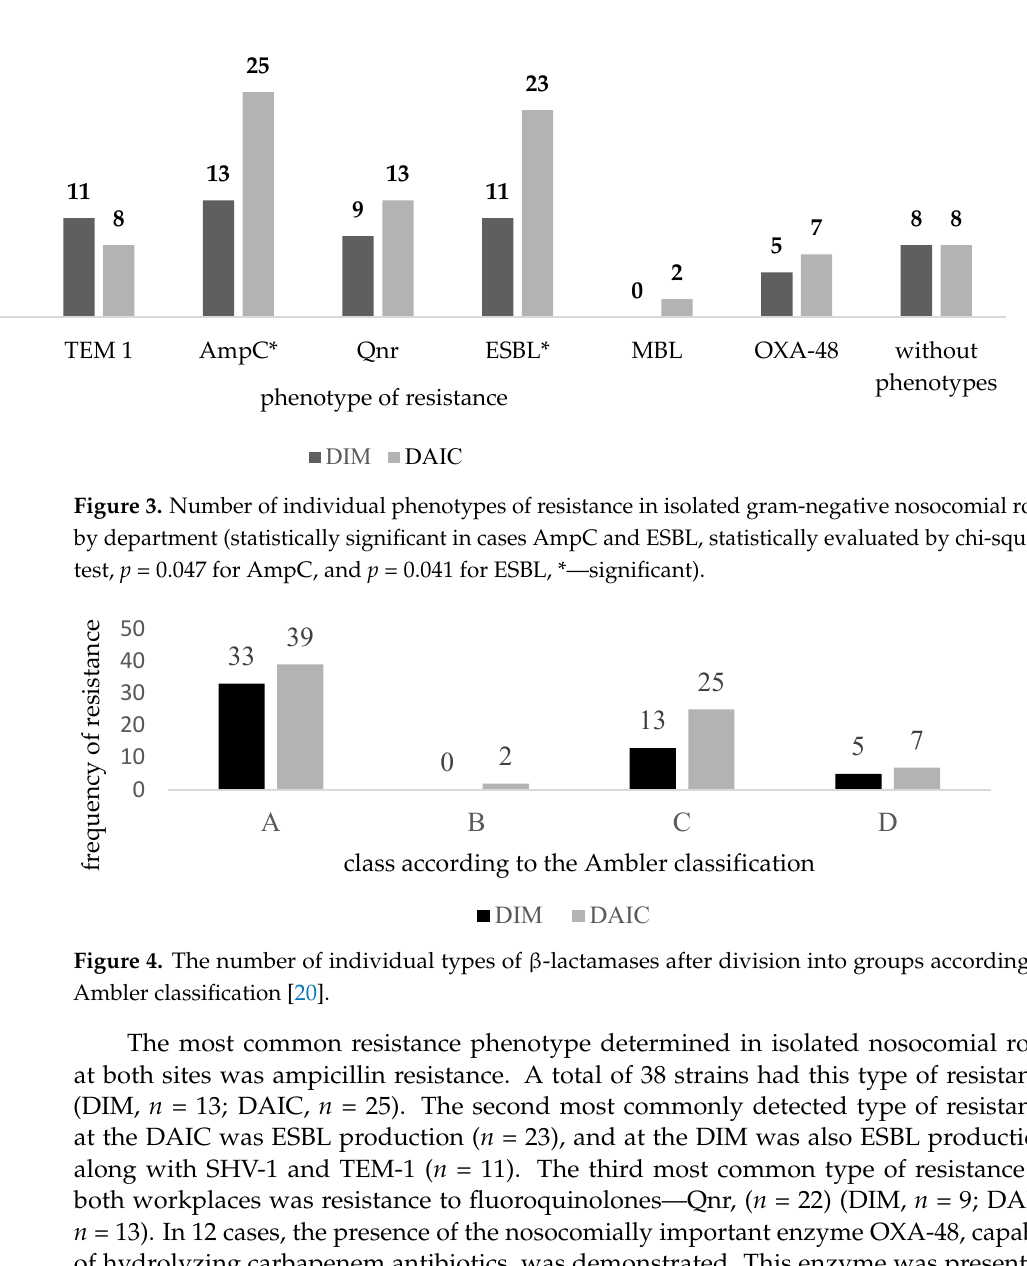
Figure 3. Number of individual phenotypes of resistance in isolated gram-negative nosocomial rods